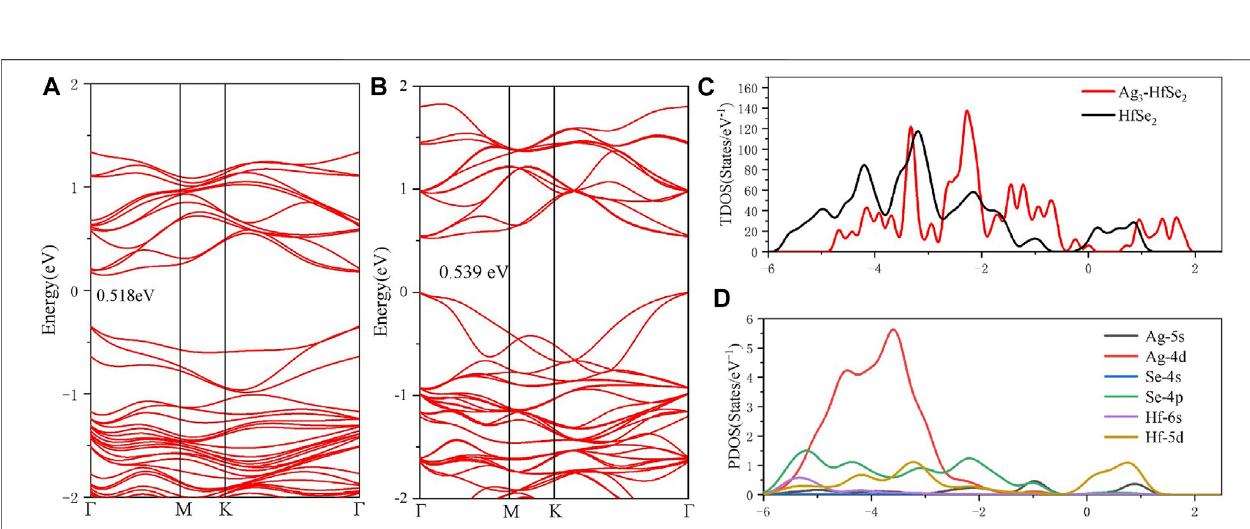
FIGURE 2 | Band structure and the TDOS and PDOS of the pristine and doped monolayers. (A) Band structure of the pristine HfSe 2 monolayer. (B – D) Band structure, TDOS, and PDOS of the Ag 3 – HfSe 2 monolayer.